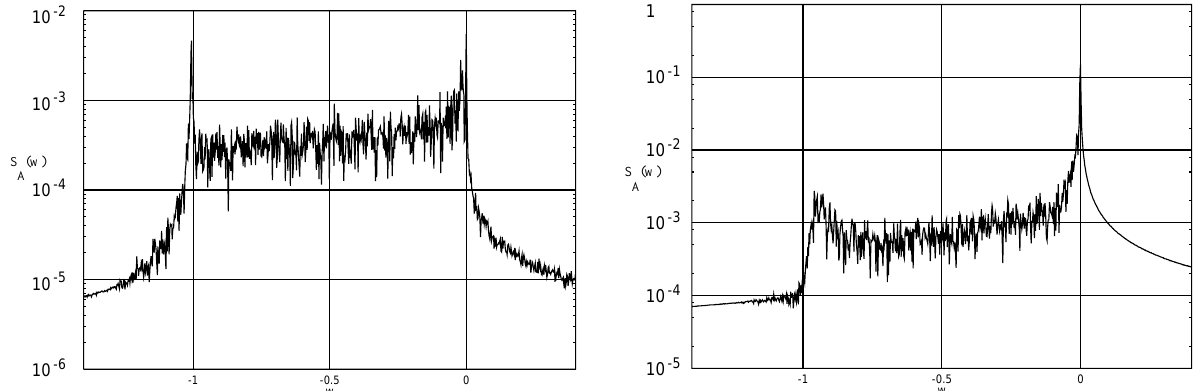
FIG. 8. Two-dimensional strong-strong simulation with j (cid:2) 2 (cid:3) (cid:1) j (cid:2) 1 (cid:3) (cid:1) 0.8 . Spectral density of centroid motion on a logarithmic scale, as a function of the distance to the nominal tune in units of j (cid:2) 1 (cid:3) . Left: N (cid:2) 2 (cid:3) (cid:1) ra 2 N (cid:2) 1 (cid:3) (cid:1) a s (cid:2) 1 (cid:3) (cid:1) a s (cid:2) 1 (cid:3) Right: N (cid:2) 2 (cid:3) , s (cid:2) 2 (cid:3) , s (cid:2) 2 (cid:3) , a (cid:1) 1.5 (parameters similar to the 1988 S pp S run). If the beams sizes are p p x x y y sufficiently unequal, the p mode